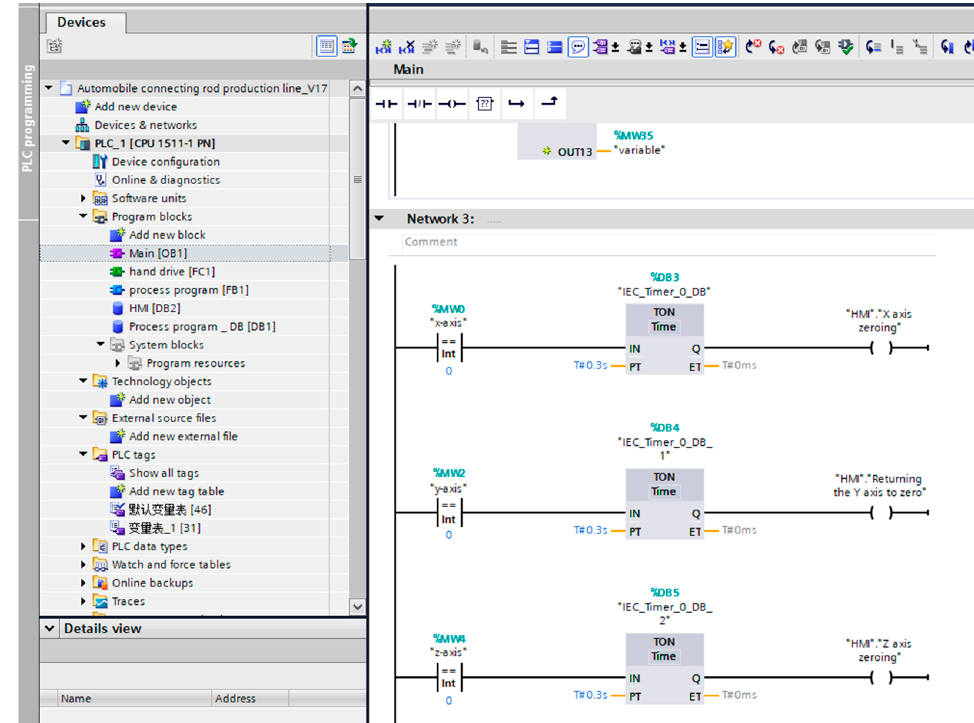
Figure 14. The X-axis, Y-axis, and Z-axis zeroing program.